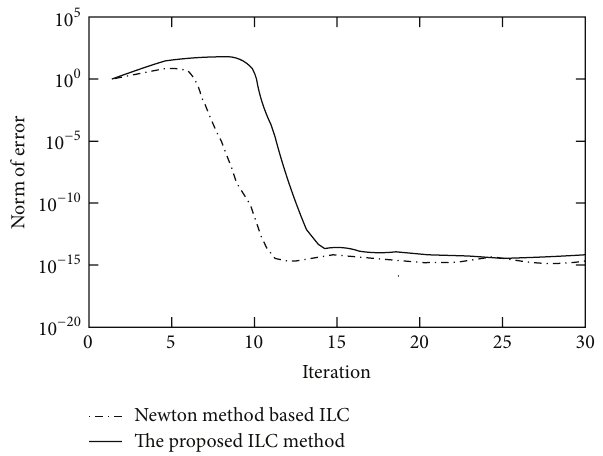
Figure 1: Simulation results of both the proposed ILC method and Newton method based ILC at the initial value 𝑢 0 = 0 with 𝜖 = 0.3 .